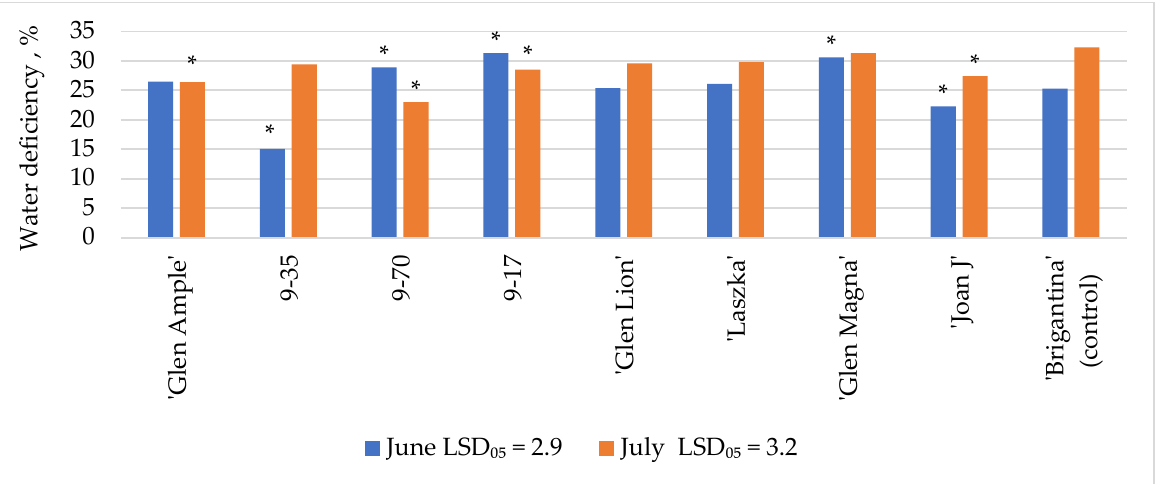
Figure 4. Water scarcity of raspberry leaves after drought simulation, % (2019–2021). *—significant differences at the 5% significance level.